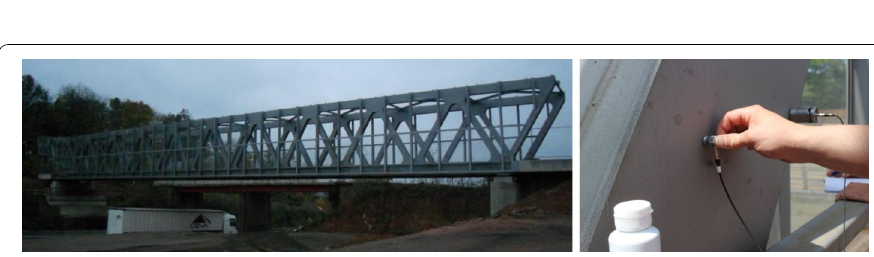
Figure 5 Left: The Caesarparkbrücke in Kaiserslautern. Right: Optimal Measurement Conditions on coated beam